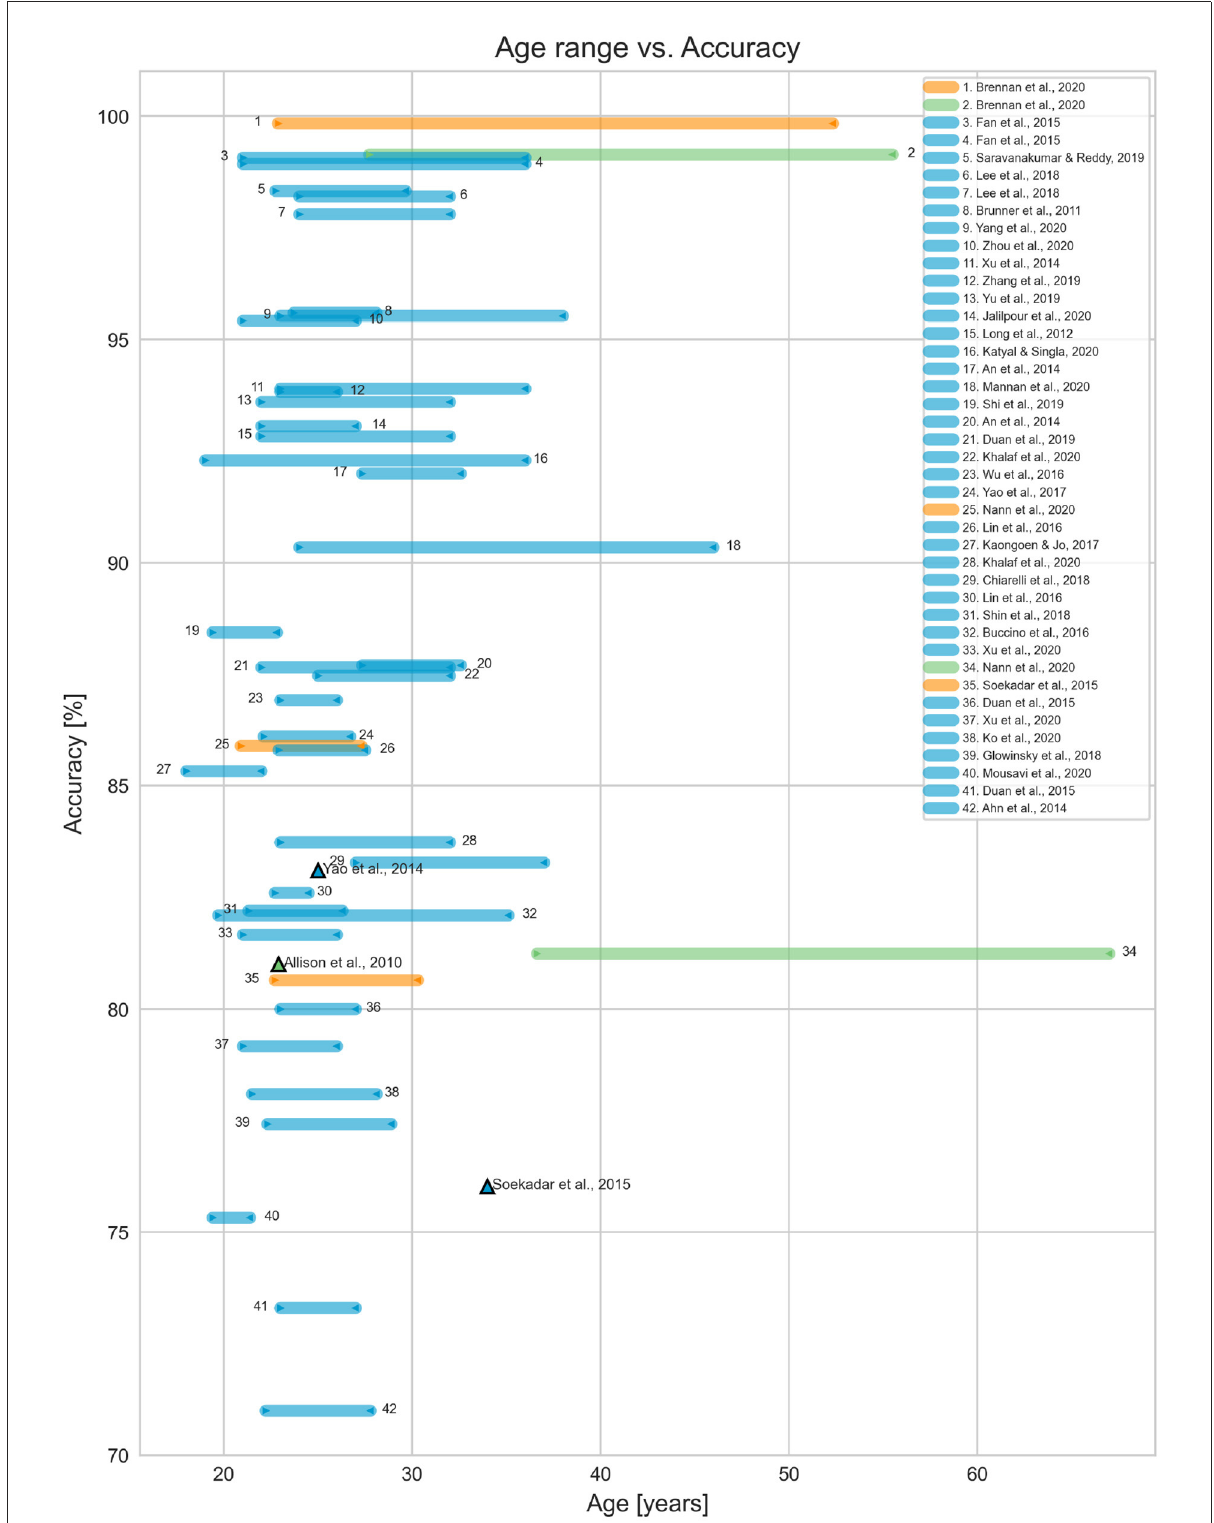
FIGURE3 System’s accuracy vs. population age. The ranges in blue only included participants without disabilities. The age ranges indicated in green and orange represent the results for participants with and without disabilities within the same paper, respectively. The triangle markers represent system results with a single